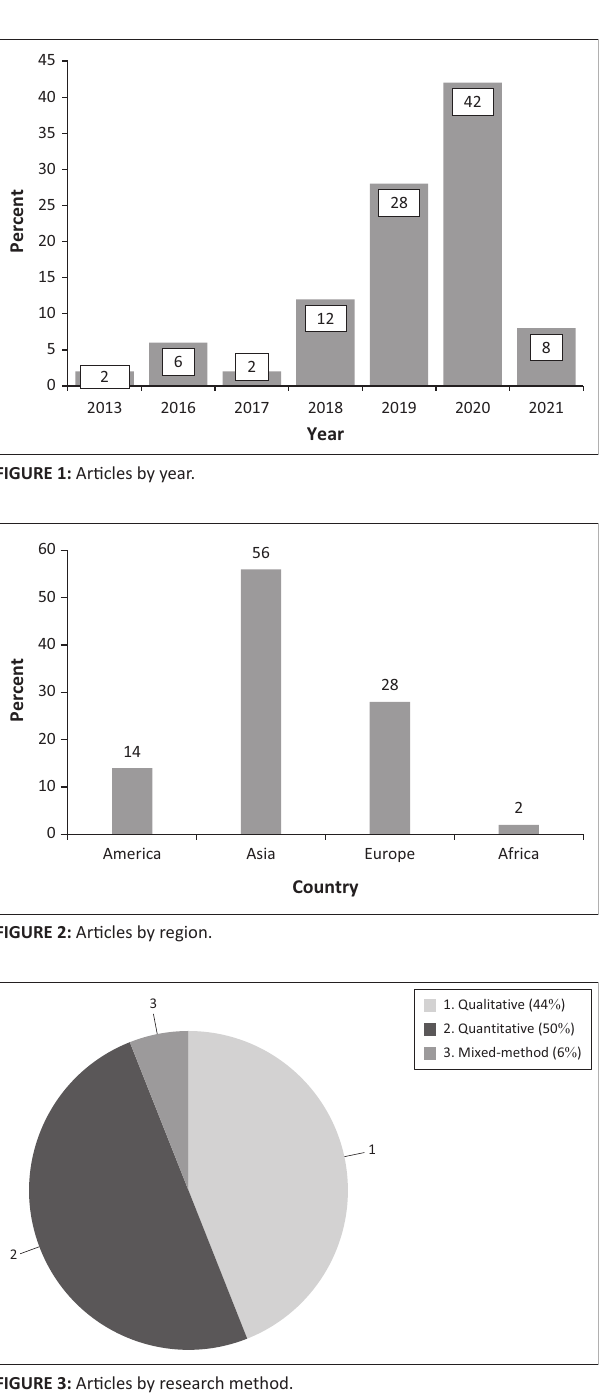
FIGURE 3: Articles by research method.